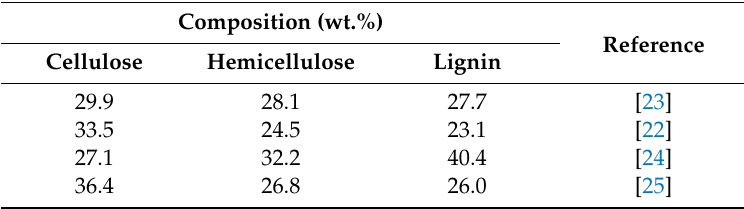
Table 3. Fiber composition of olive